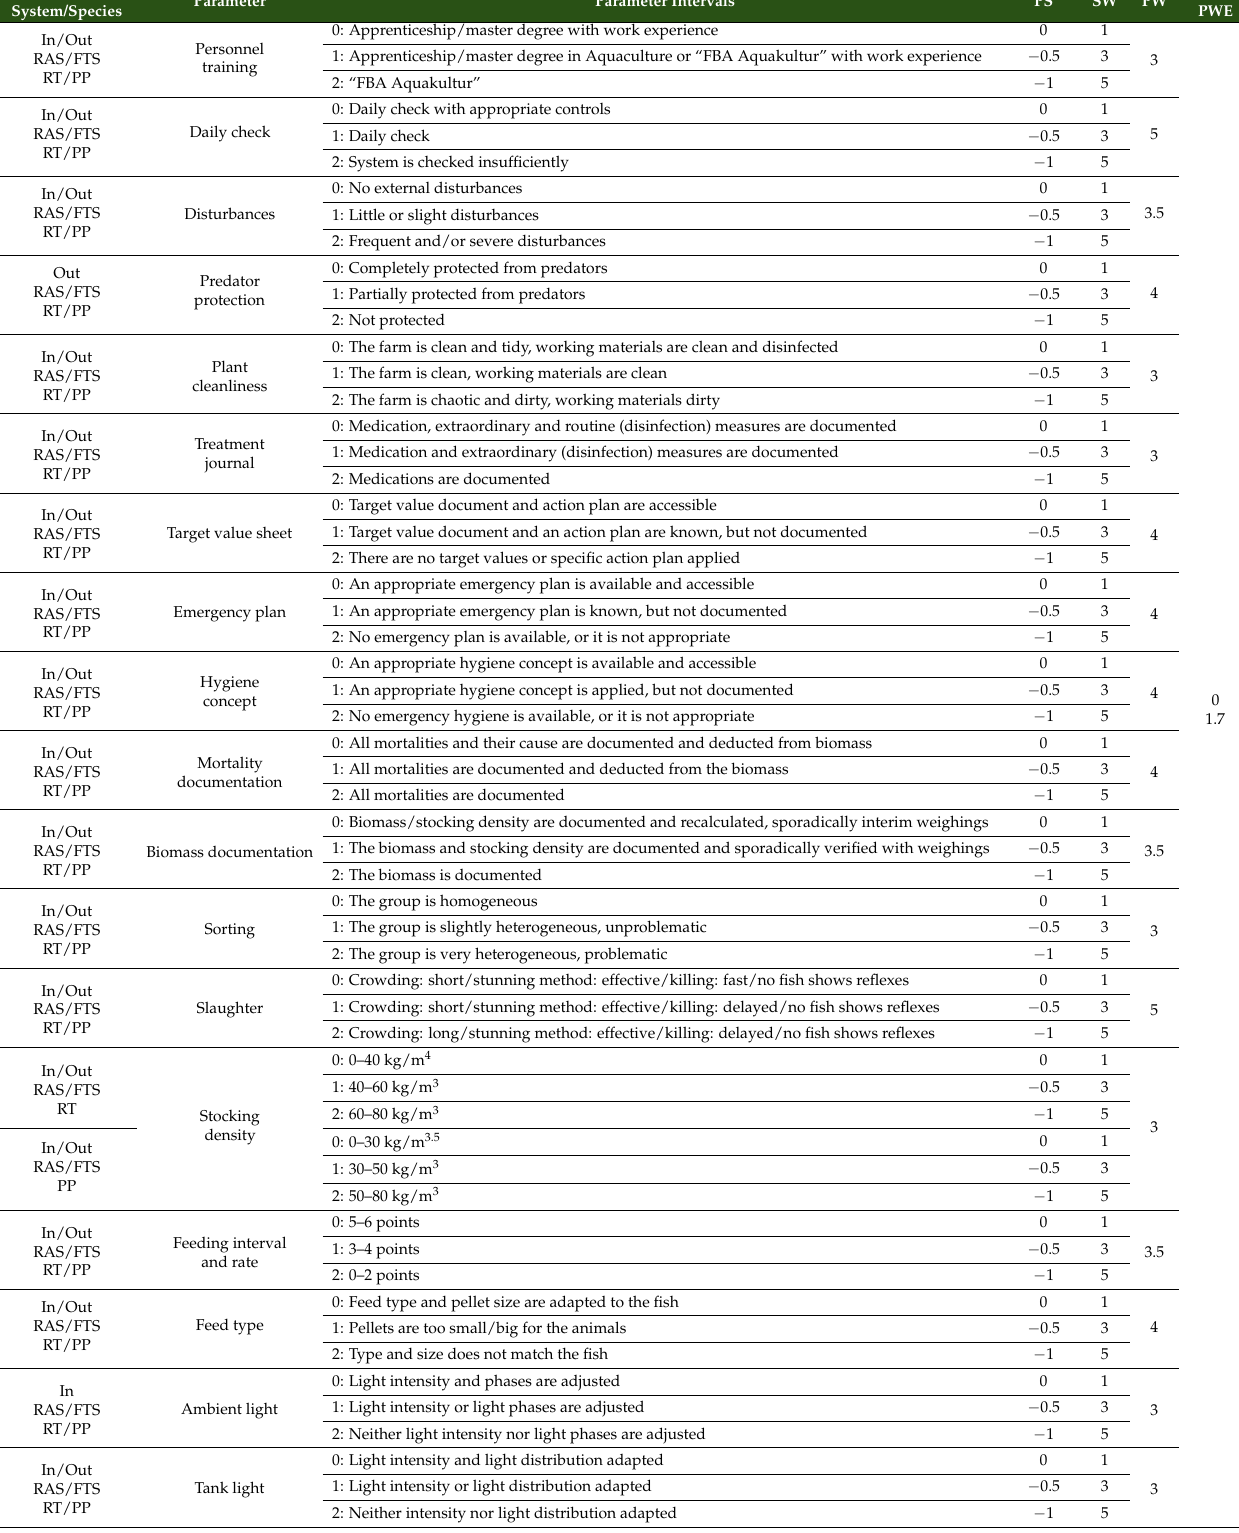
Table A1. Module farm management. In = indoor, Out = outdoor, RAS = recirculating aquaculture system, FTS = flow- through system, RT = rainbow trout, PP = pikeperch, PS = parameter score, SW = score weight, PW = parameter weight, SWE = score weight exponent, PWE = parameter weight